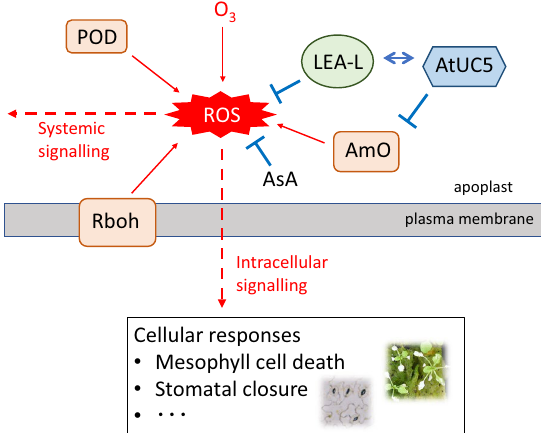
Figure 6. ROS generation/signalling and hypothetical acting sites of AtUC5 at the apoplastic region of O 3 - exposed leaf cells. AmO amine oxidase, AsA ascorbic acid, LEA-L late embryogenesis abundant protein-like protein, POD cell-wall peroxidase, Rboh respiratory burst oxidase